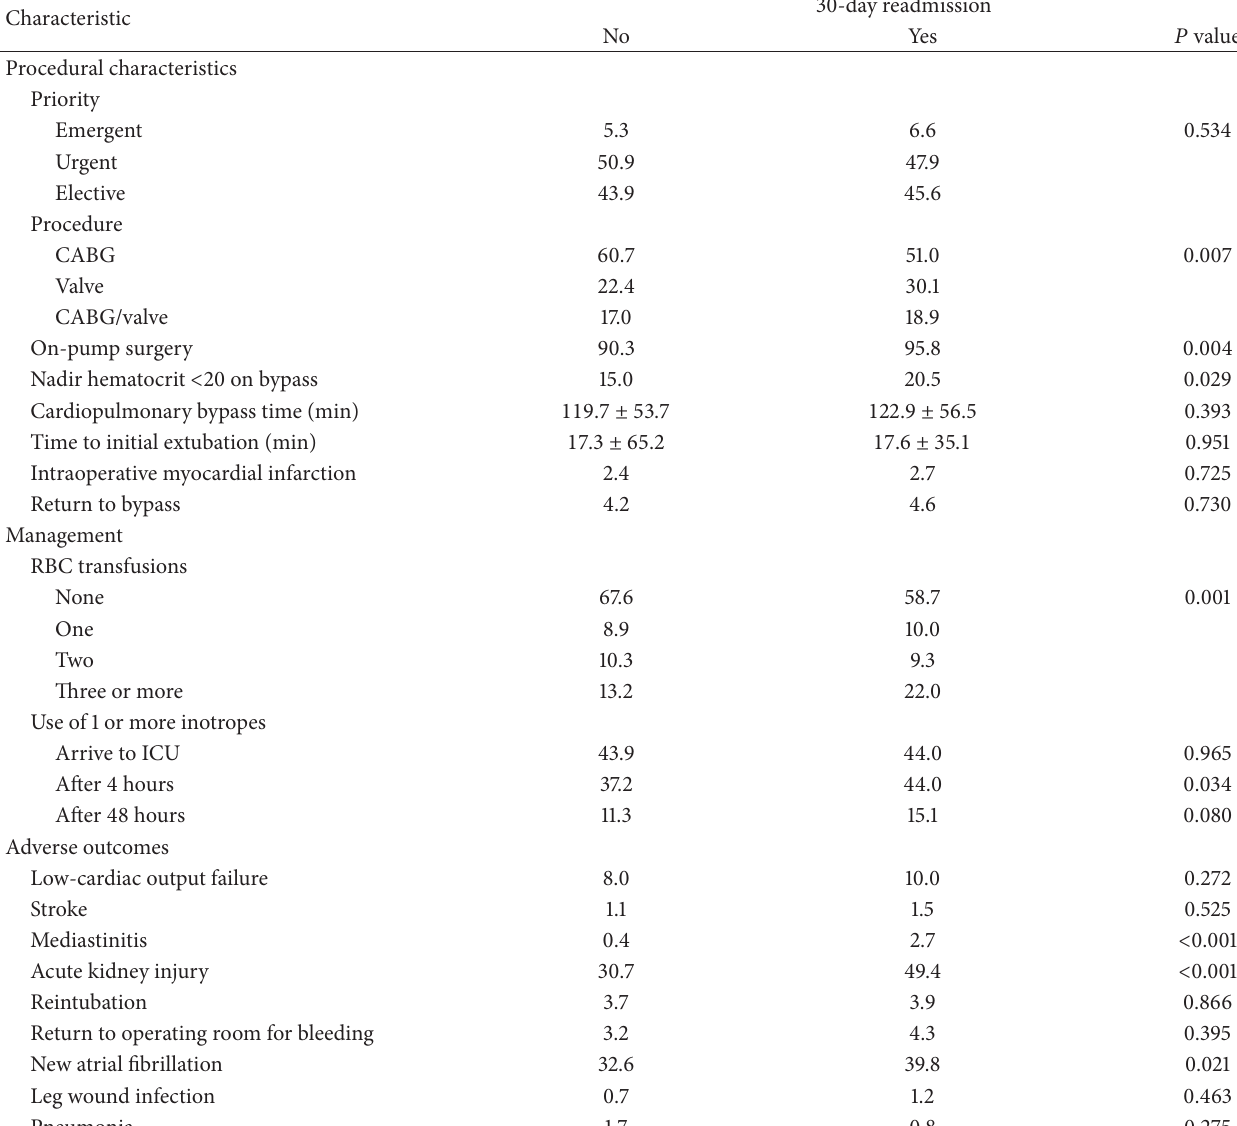
Table 2: Procedural characteristics and outcomes of patients with or without 30-day readmission.